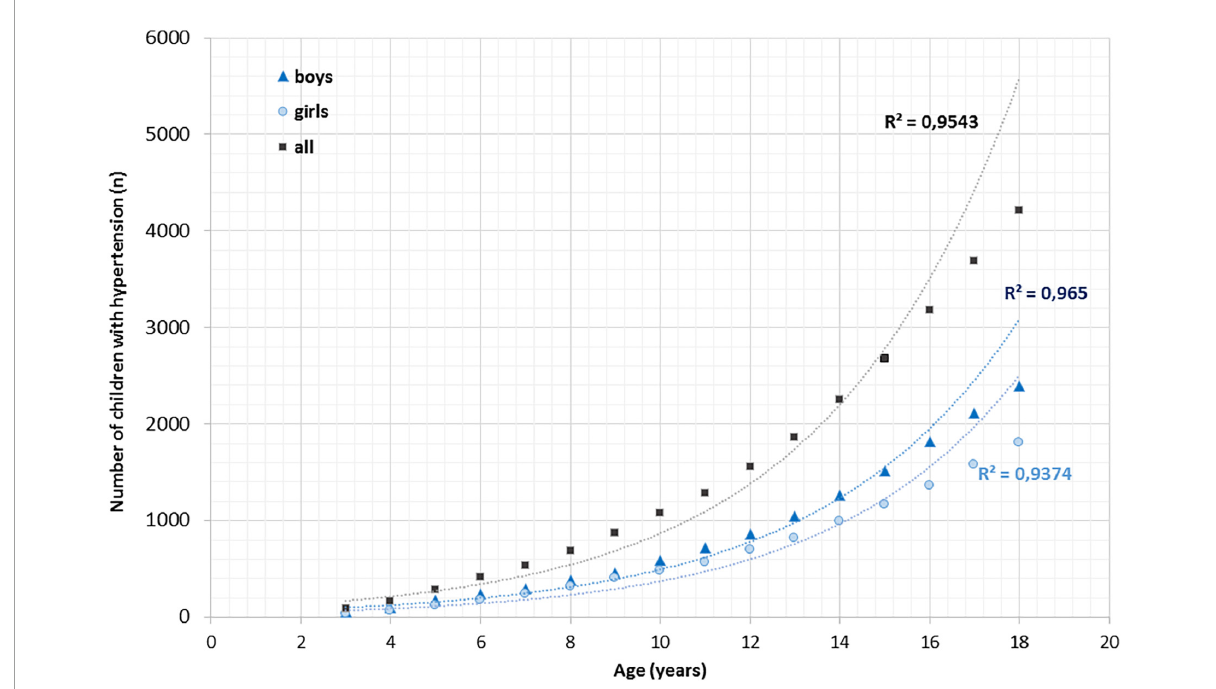
FIGURE2 Exponential correlation between age and cumulative number of children with hypertension.